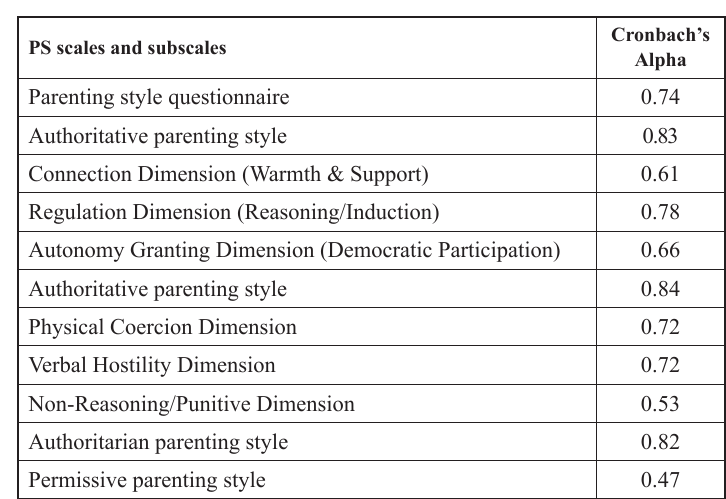
Table 1. The level of internal consistency of PS scales and subscales PS scales and